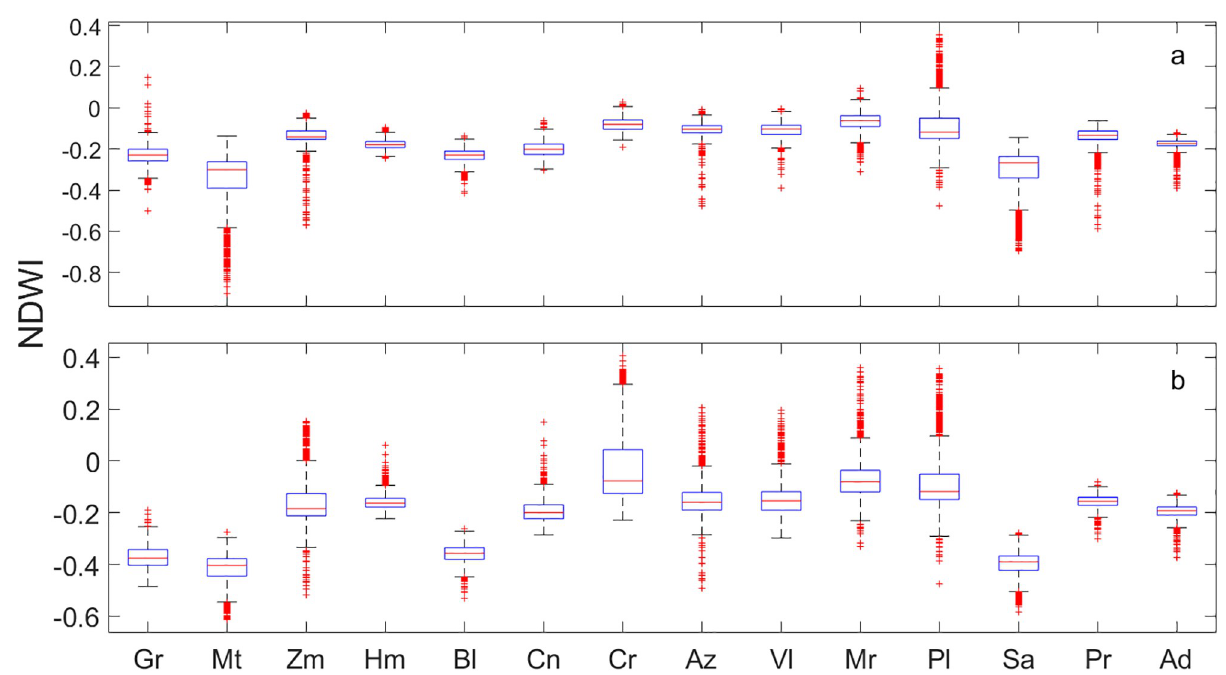
Fig 4. Comparison of NDWI values at waterholes detected during a) the wet season (November to February), and b) dry season (May to July) in Sierra Santa Isabel, Baja California, Mexico. Gr = Grande, Mt = Matomi, Zm = Zamora, Hm = Hemes, Bl = Blancas, Cn = Canelo, Cr = Cordero, Az = Zamora, Vl = Volca´n, Mr = Miramar = Pl = Palmito, Sa = San Agustı´n, Pr = Peralta, Ad = Dulce.